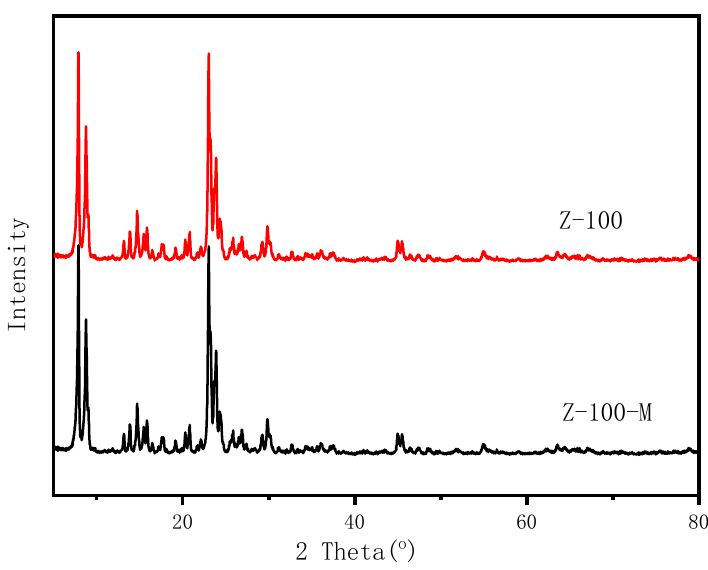
Figure 5. The XRD patterns of different types of ZSM-5 zeolite.